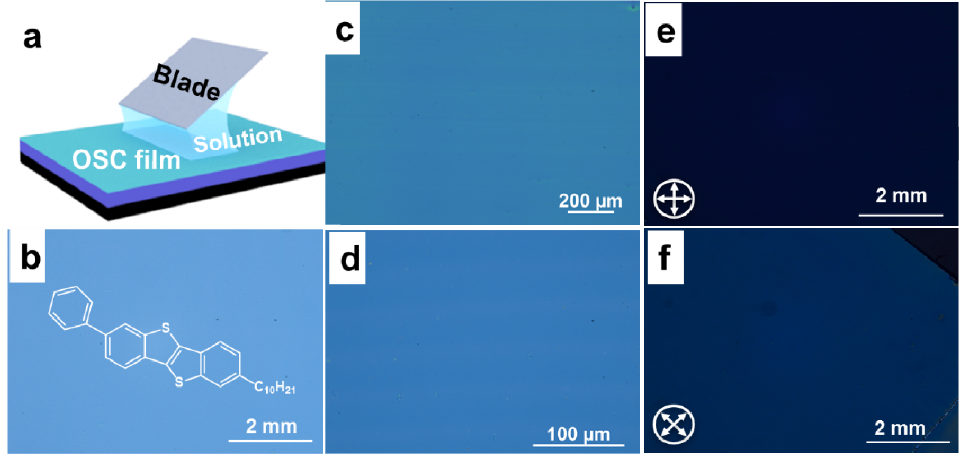
Figure 1. ( a ) Schematic of blade-coating. ( b – d ) Optical microscopy (OM) and ( e , f ) polarized optical microscope (POM) images of the crystalline films of